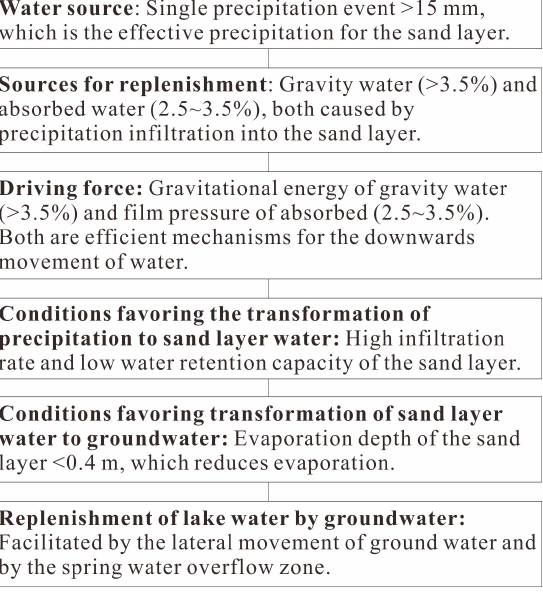
Figure 9. Summary of the mechanism of groundwater recharge by precipitation.